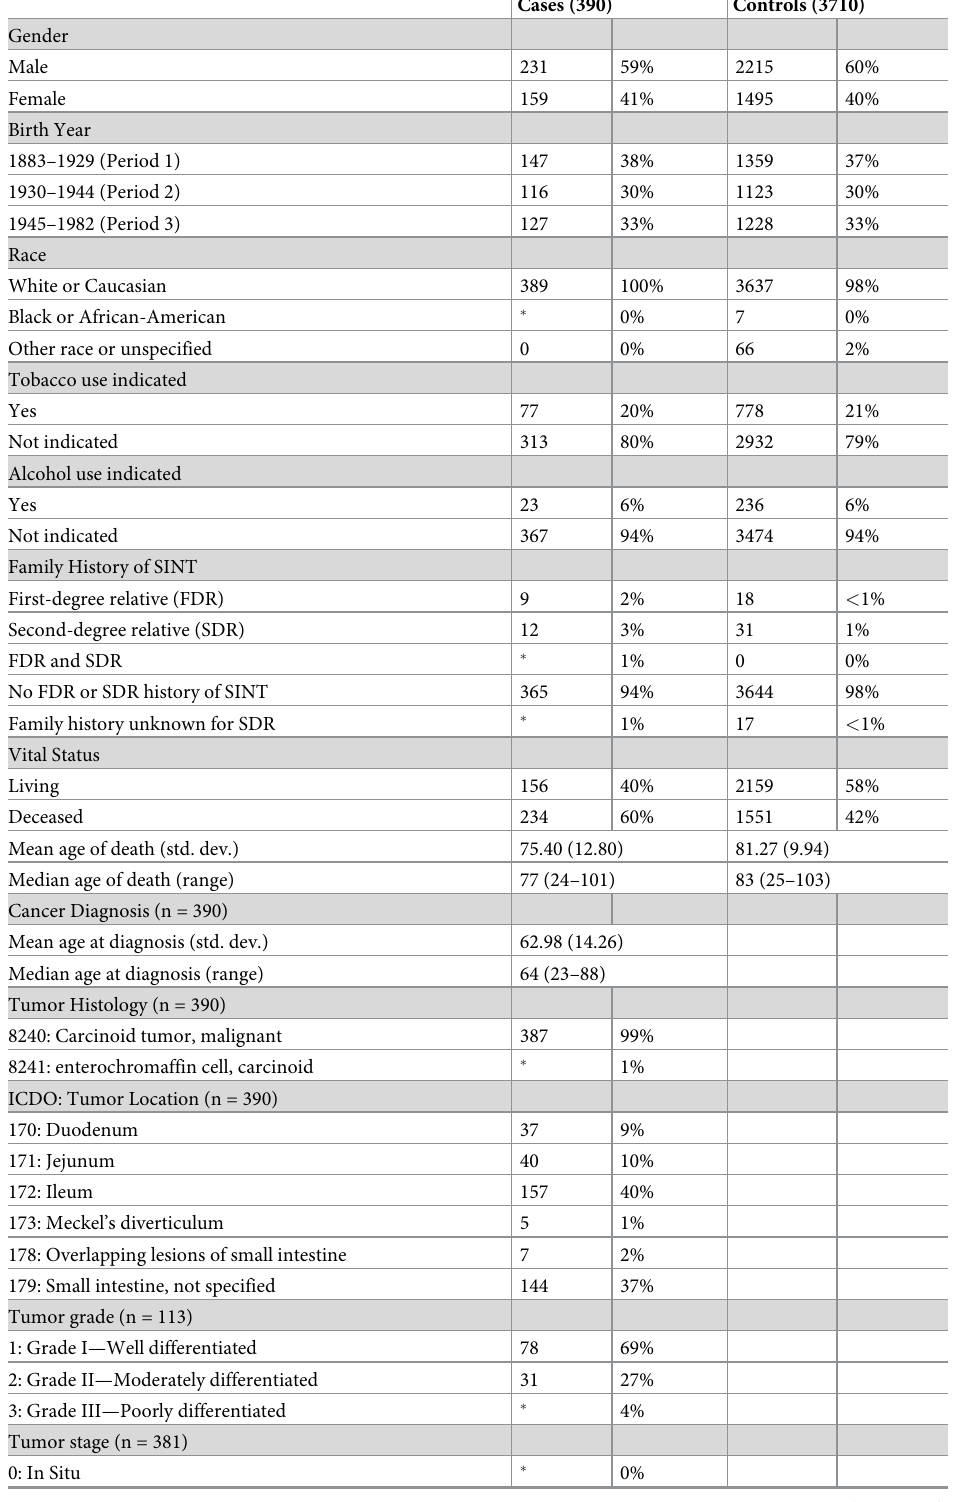
Table 2. Demographics of cases and